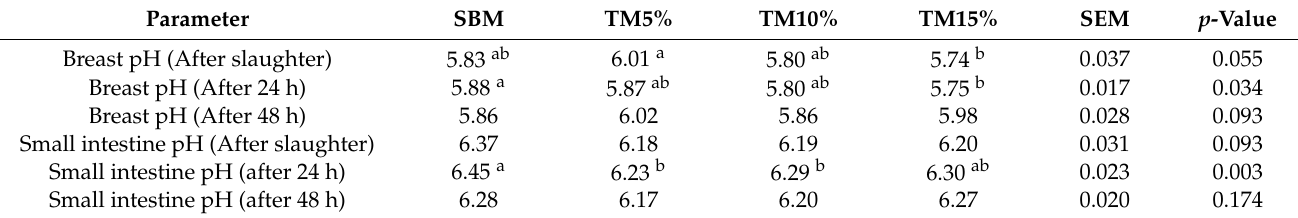
Table 5 presents pH values taken 15 min after slaughter followed by another reading after 24 h and 48 h respectively. The breast meat pH taken after slaughter was different ( p < 0.05) between the TM5 and TM15 groups, with the highest reading (pH 6.0) in the TM5 group. The small intestine pH taken from the jejunum after 24 h was the highest in the SBM group ( p < 0.05). Table 5. The pH values of breast and small intestine taken from 60-day-old mixed-sex Boschveld indigenous chickens.